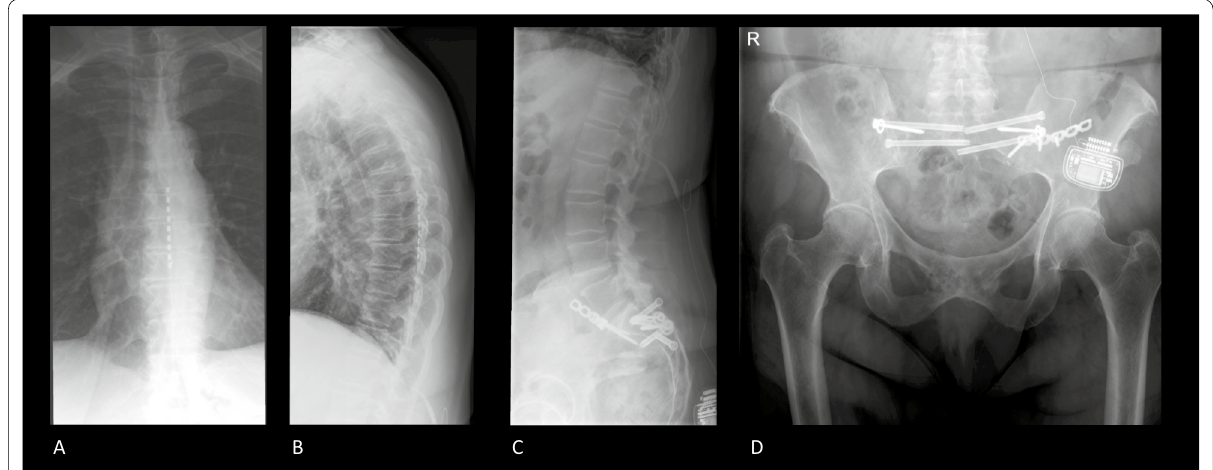
Fig. 2 Radiographs of the thoracic- and lumbar spine and pelvic region of an FBSS patient. A The spinal cord stimulation electrode